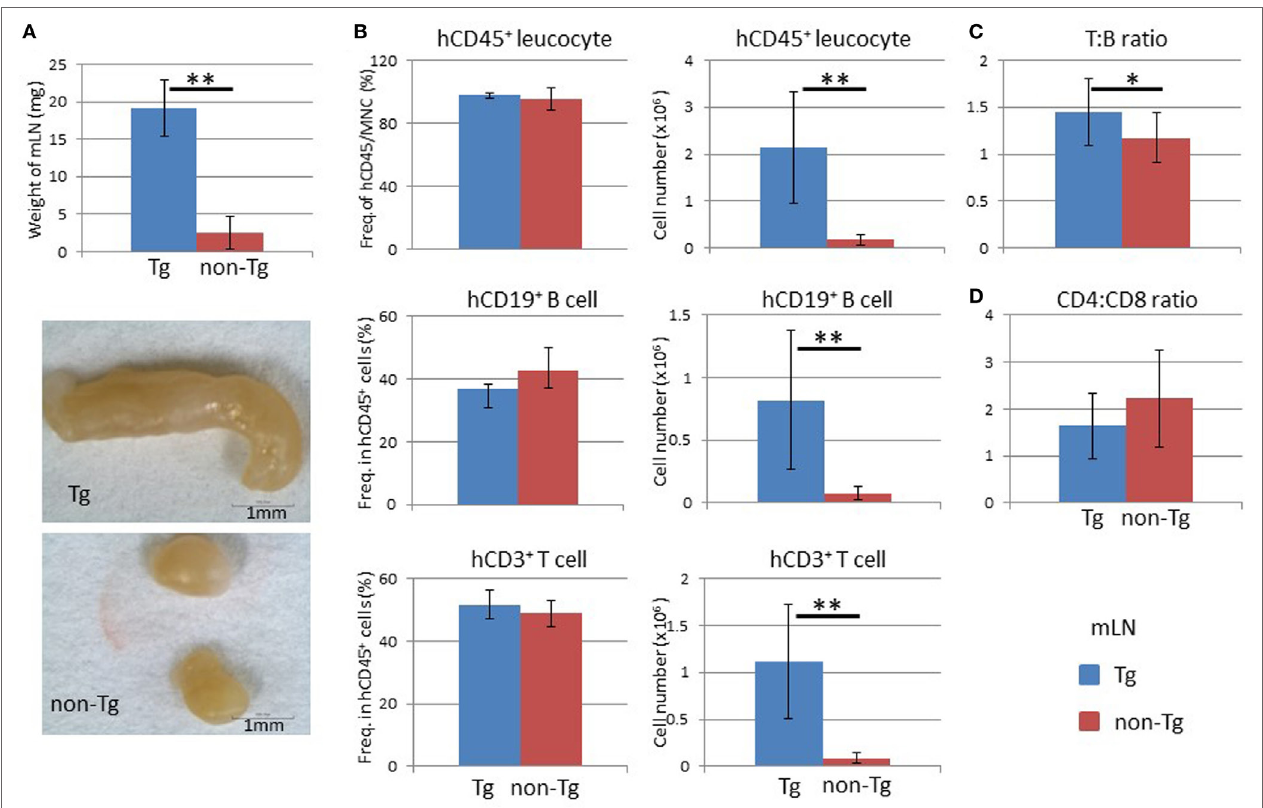
FigUre 7 | Analysis of mesenteric lymph nodes (mLNs). (a) Weight of mLNs. mLNs were isolated at 24 weeks after hematopoietic stem cell transplantation. Representative photographs of mLNs from human HSC-engrafted NOG-pROR γ t- γ c Tg and non-Tg mice. (B) Frequency and absolute number of human leukocytes. Human mononuclear cells were isolated from mLNs and analyzed by fluorescence-activated cell sorting. The number of human CD45 + leukocytes was obtained by multiplying the total number of mononuclear cells by the frequency of human CD45-positive cells. (c) Human T to B cell ratio. (D) Human CD4 + T cell to CD8 + T cell ratio. Mean ± SD from NOG-pROR γ t- γ c Tg ( n = 12) and NOG non-Tg mice ( n = 11). Student’s t -test was performed to assess statistical significance (* p < 0.05 and ** p <